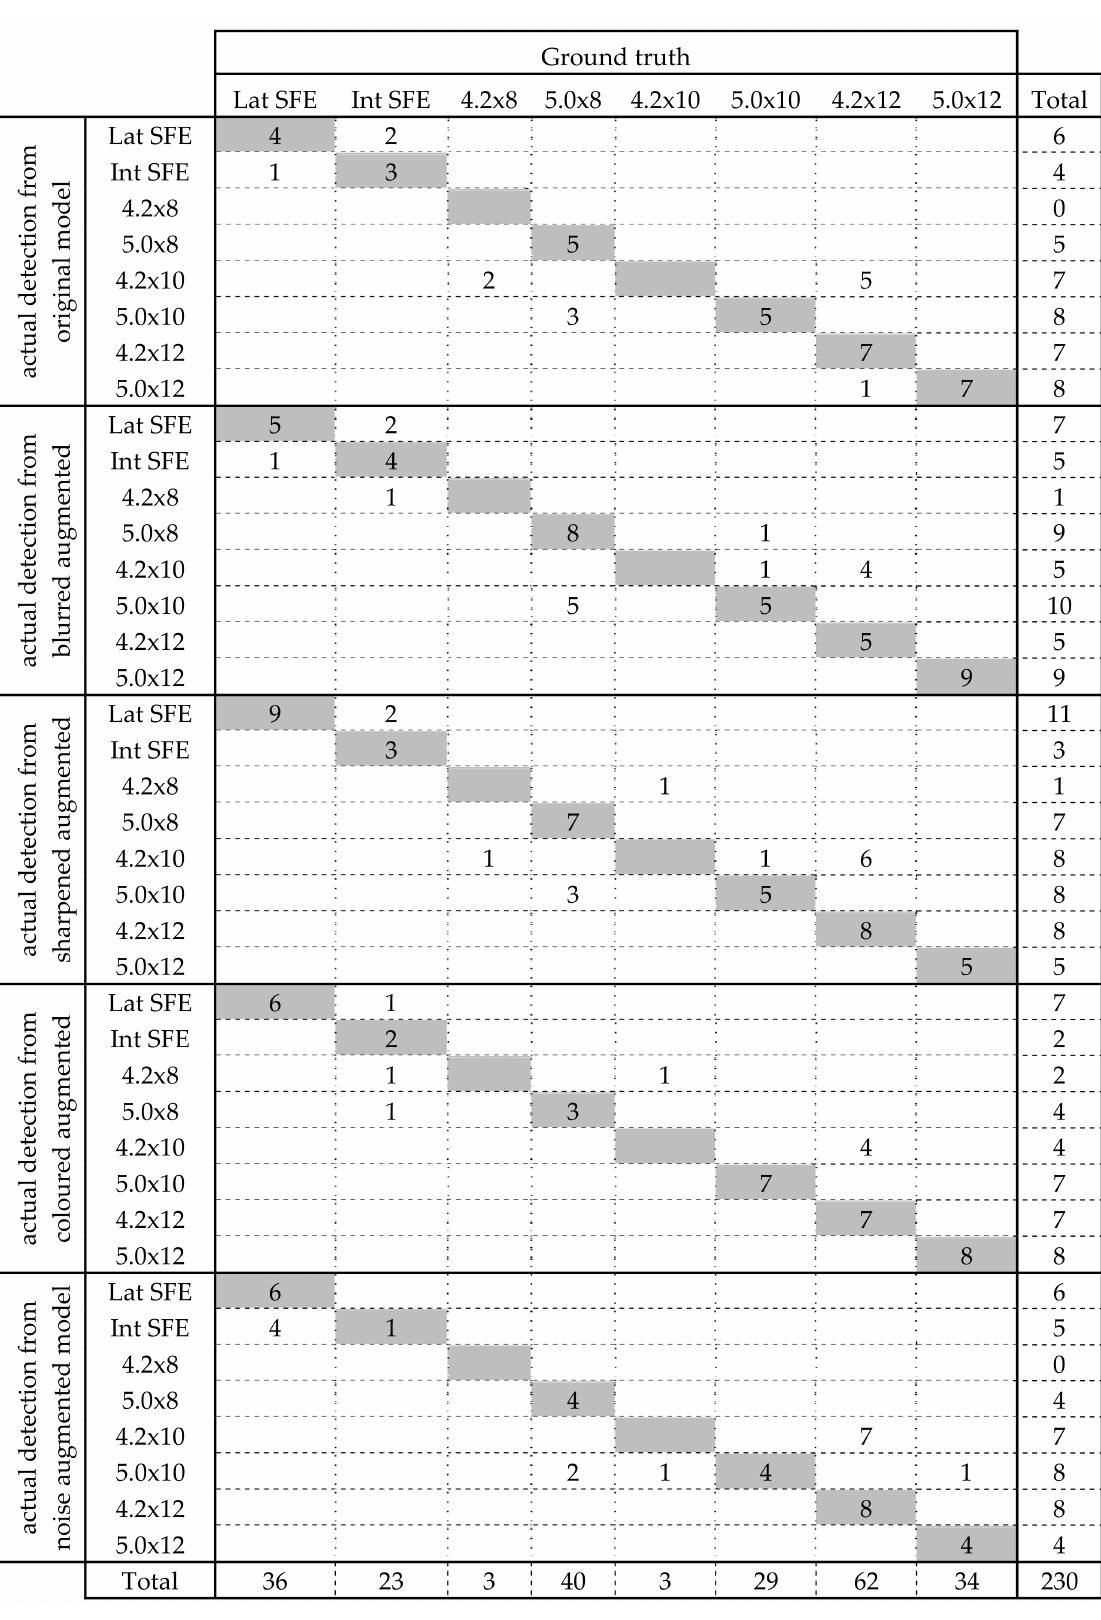
Figure 5. The confusion matrix table between each detection in each model for the panoramic